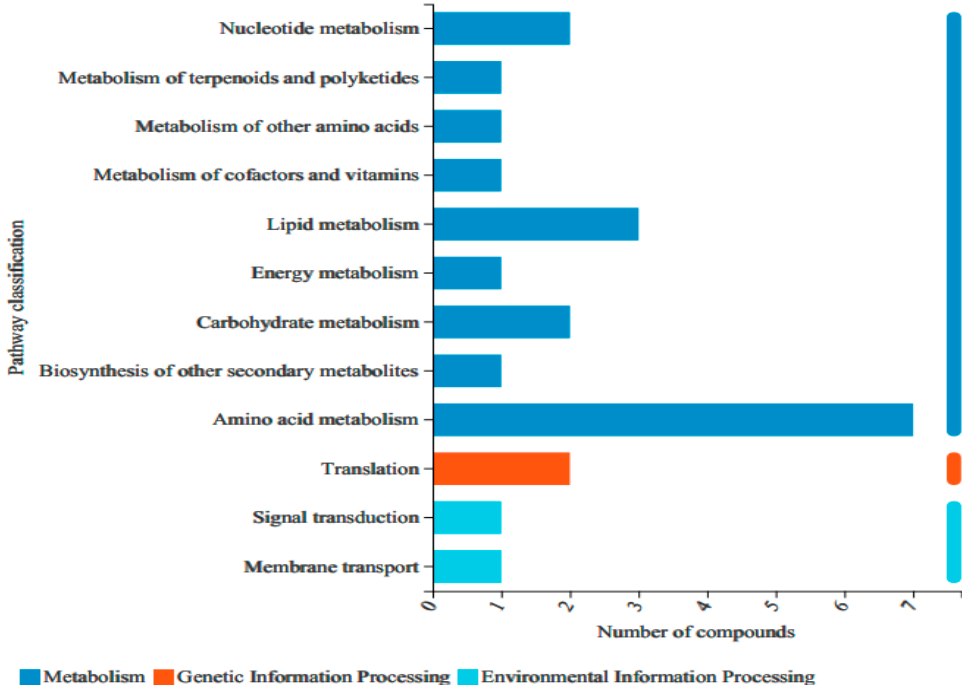
Figure 6. Statistical Diagram of KEGG Functional Pathway in Z-2-GS-2 vs. GS groups of Vigna angularis . Figure 6. Stati stical Diagram of KEGG Functional Pathway in Z-2-GS-2 vs. GS groups of Vigna an- Note: The ordinate is the second classification of the KEGG metabolic pathway, and the abscissa is the number of metabolites annotated to this pathway.